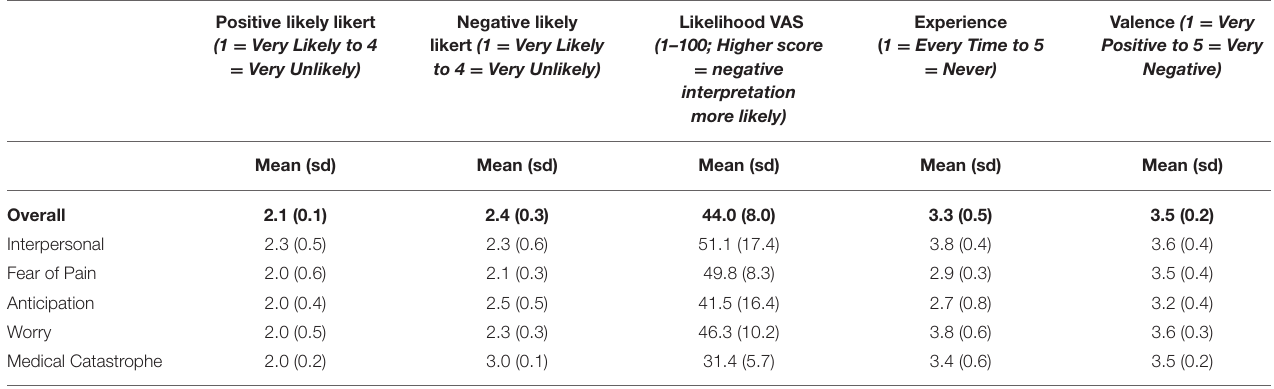
TABLE 3 | Development phase mean values for 5 scenarios included in each factor.